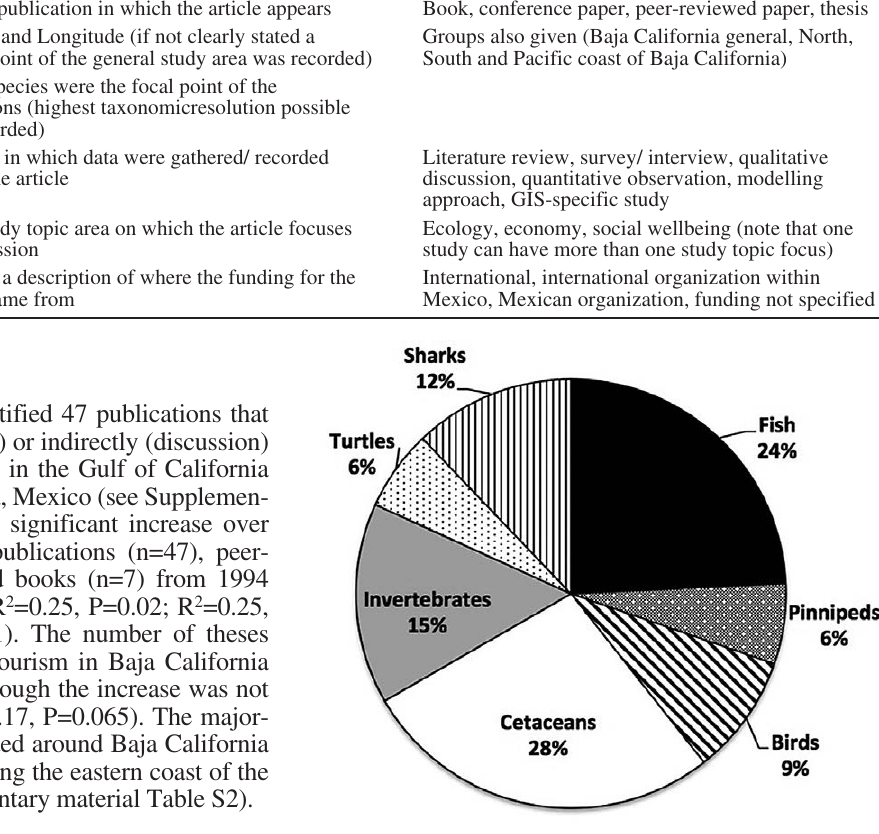
Fig. 3. – Pie chart showing the percentages of publications discuss- ing the different animal groups noted in the review (note: total num- ber of species-specific